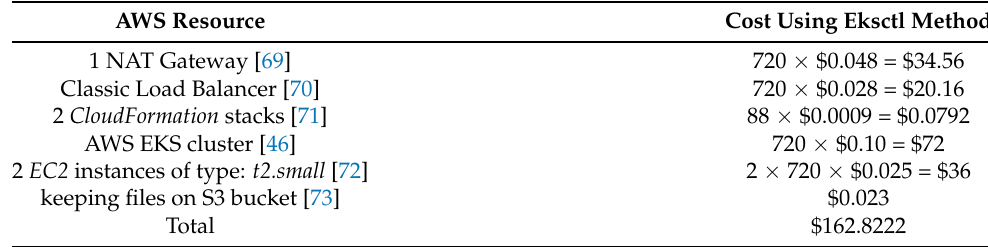
Table 3. Expected cost of running a Kubernetes cluster created with eksctl for one month. AWS Resource Cost Using Eksctl